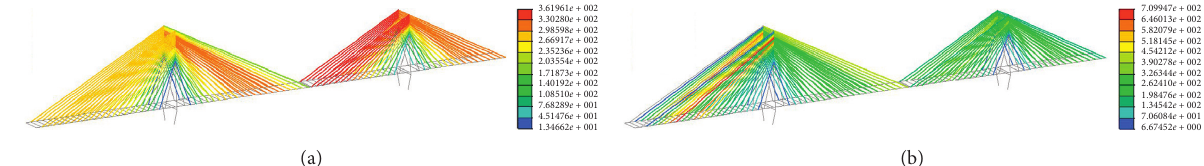
Figure 11: Cable force distributions for (a) intact case and (b) damaged case (unit: tonf).